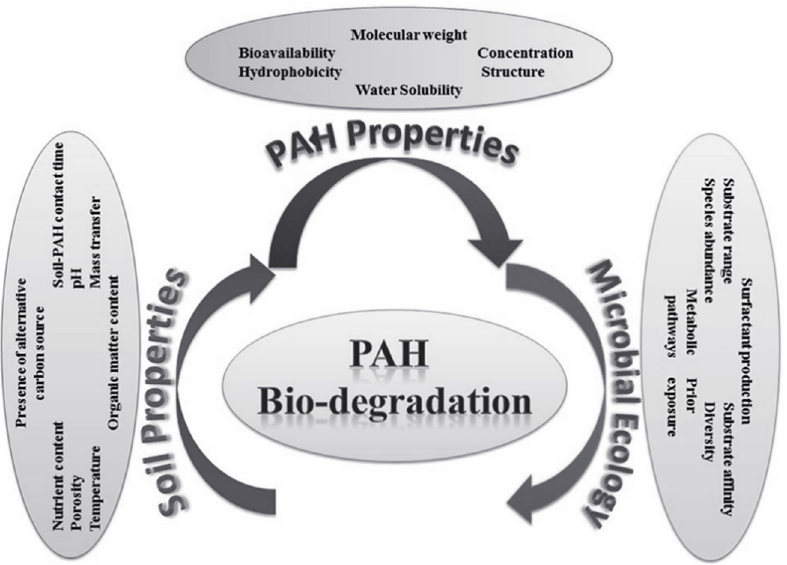
Figure 3. Various variables, both abiotic and biotic, influence the PAH ability to degrade in soil [58]. Metaproteomics and metabolomics have recently been used to explore many facets of environmental microbiology and have shown promise for application in